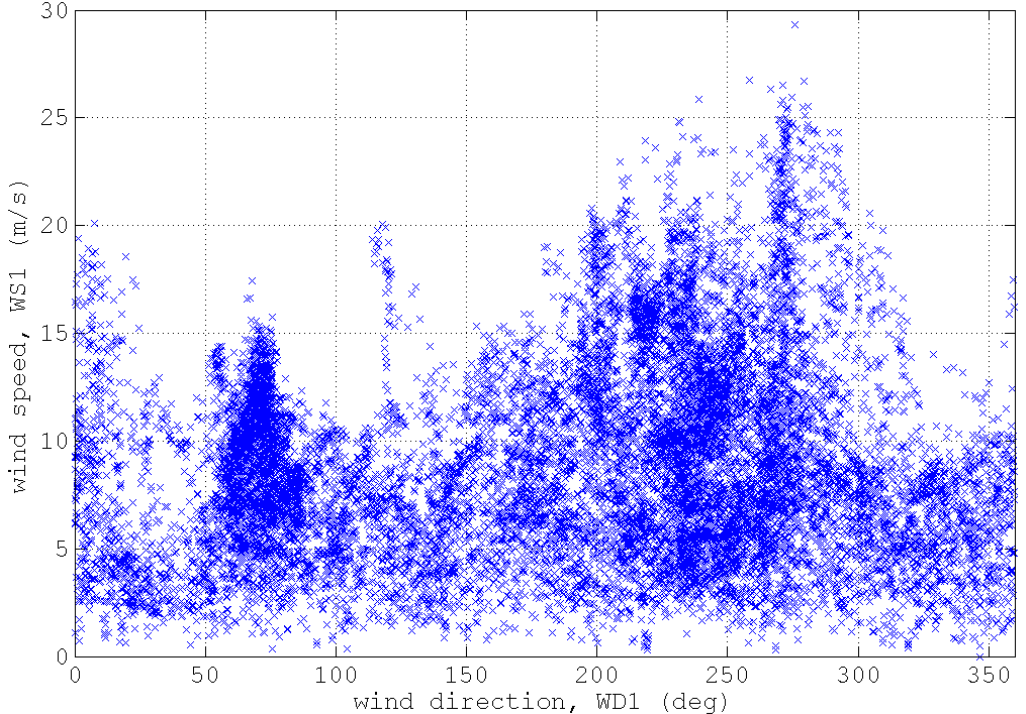
Figure 2. Wind speed and direction at top of mast during measurement period (unfiltered